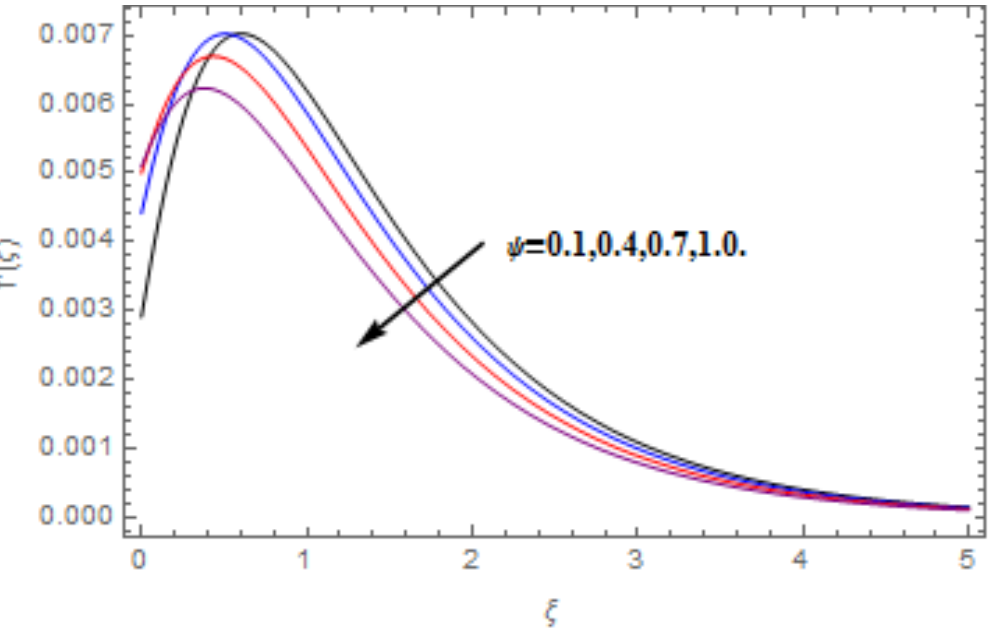
Figure 8. Varation in f (cid:48) ( ξ ) against ψ , when M = 0.2, Nt = Nb = 0.5, Le = 1.0, Ec = 1.0, Pr = 1.2, γ = 0.1, κ =